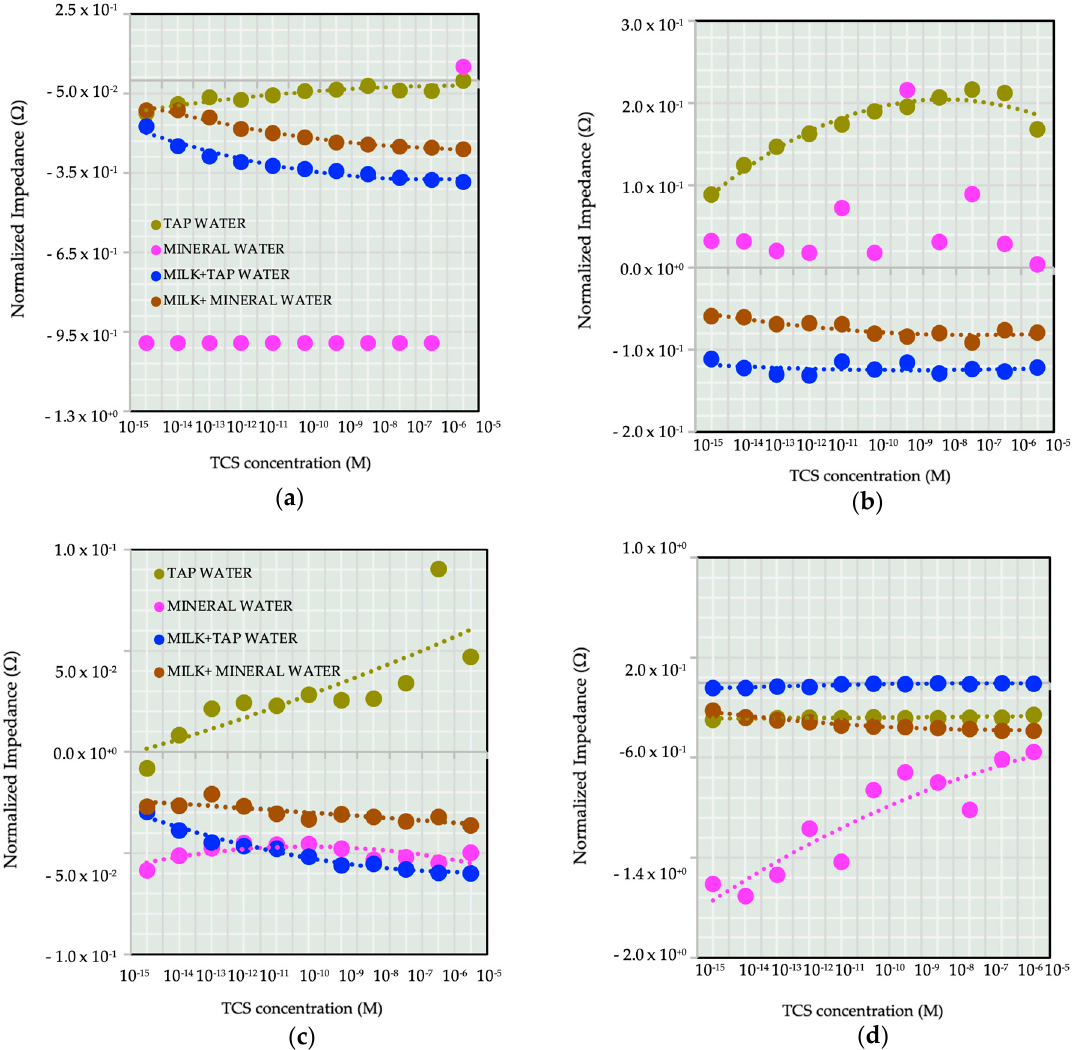
Figure 2. Normalized impedance ( Ω ) versus TCS concentrations at fixed frequencies: ( a ) MWCNT5 at 10 Hz; ( b ) MWCNT10 at 100 Hz; ( c ) MWCNT10-85 at 10 Hz; ( d ) TiO 2 at 1000 Hz when immersed in tap water, mineral water, milk-based solution prepared with tap water or mineral water. The lines in the graphs are only